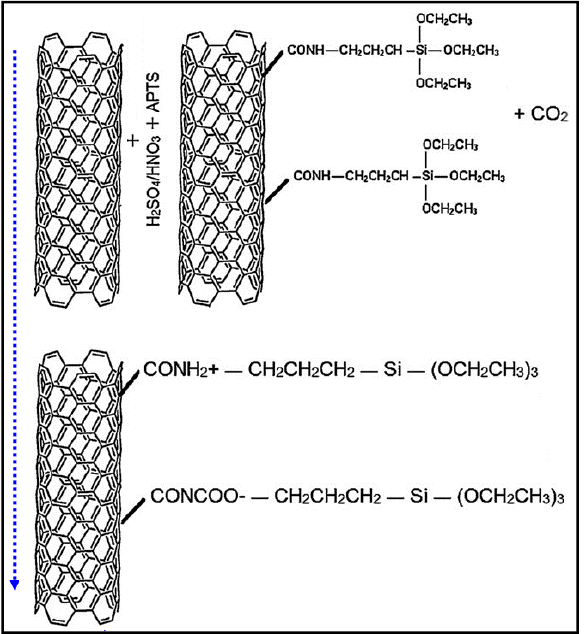
Figure 2. Mechanism of treatment of MWCNTs with acid and amine.